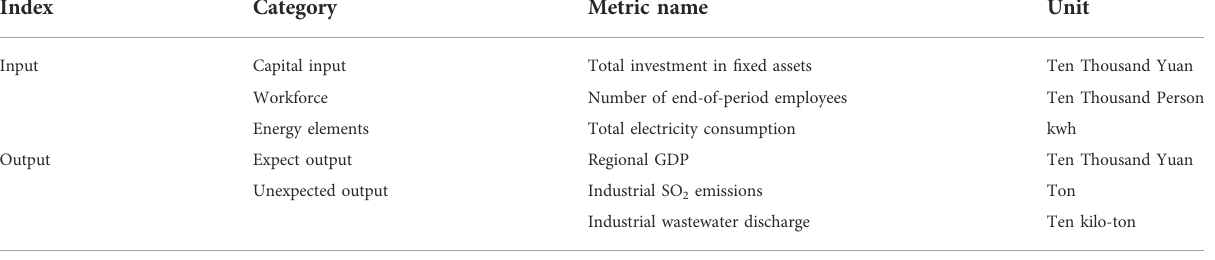
TABLE 2 Urban environmental resource ef fi ciency evaluation index system.